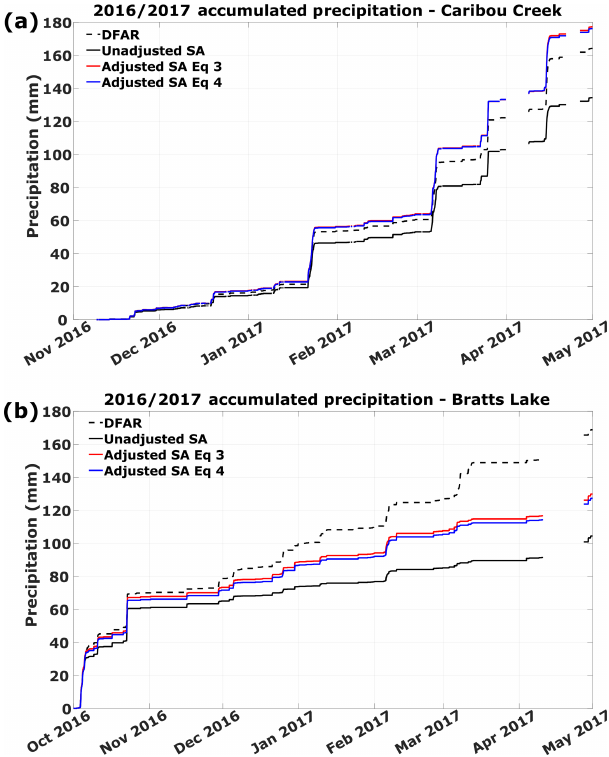
Figure 8. The 2016/2017 winter accumulated precipitation time se- ries from (a) Caribou Creek and (b) Bratt’s Lake showing the unad- justed single Alter Geonor T-200B (solid black), the adjusted single Alter Geonor T-200B (red and blue solid; via the SPICE Eqs. 3 and 4 transfer functions from Kochendorfer et al., 2017b), and the DFAR (dashed